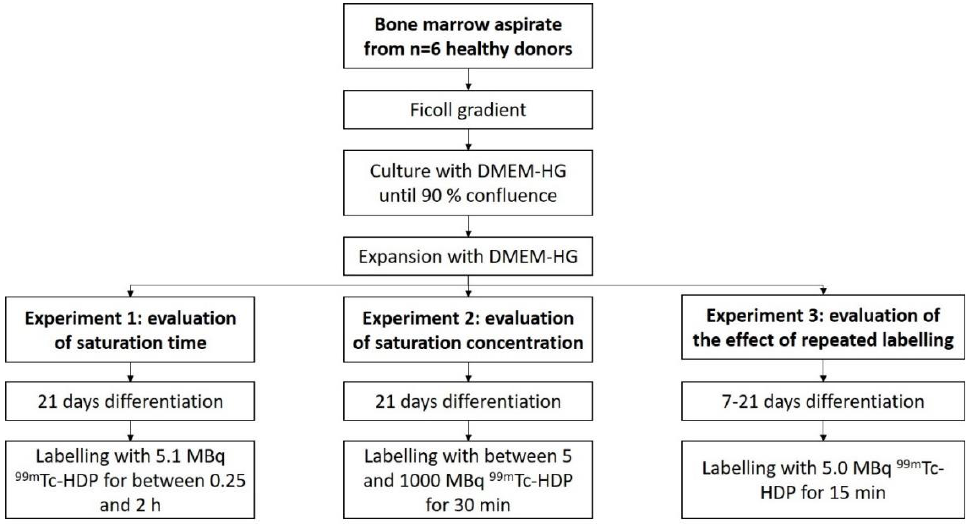
Figure 7. Overview of study design.